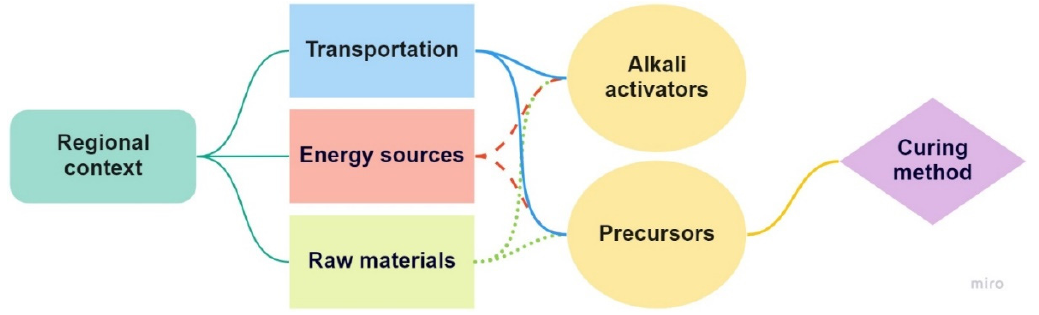
Figure 8. Interconnectivity of the major contributors to the environmental performance of AABs.